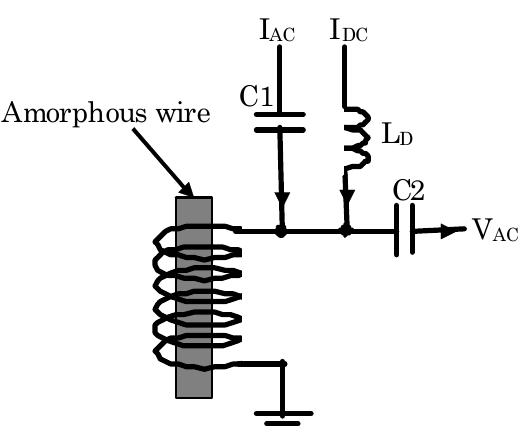
Figure 2. MI element composed of (Fe 0.06 Co 0.94 ) 72.5 Si 2.5 B 15 (FeCoSiB) amorphous wire without the electrical connection with the amorphous wire.